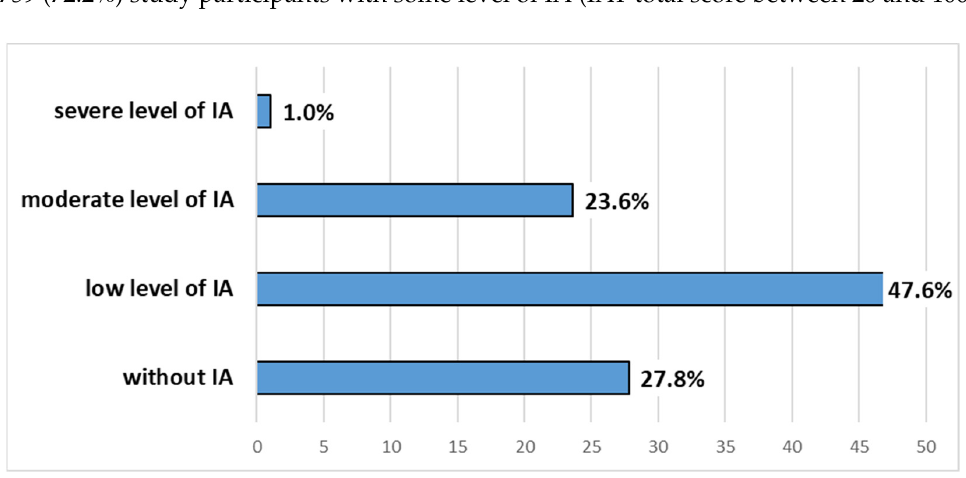
Figure 1. All study participants according to the IAT total score. Table 2. Participants with or without IA according to their sociodemographic characteristics.